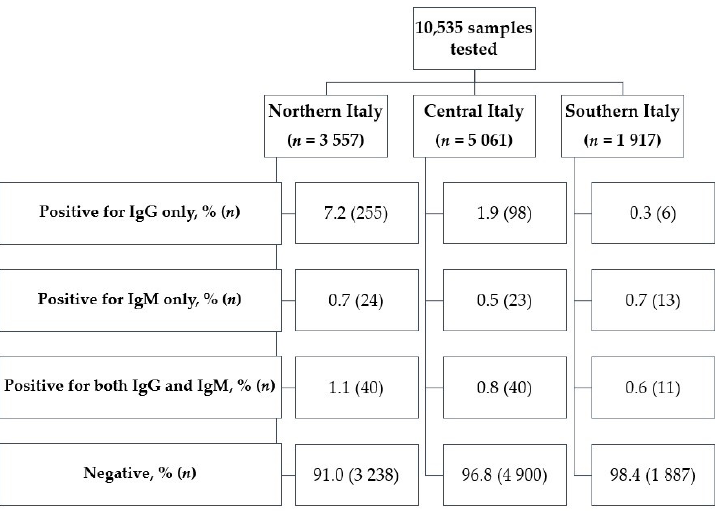
Figure 1. Distribution of seropositive and seronegative police officers, by macro-region. In the multivariable logistic model (Table 3), the main effect of the independent variables of geographic area, prior olfactory and gustatory dysfunctions and ILI were significantly associated with a positive test result. Moreover, two interaction terms proved statistically significant. First, males with dysosmia had a 91.9% probability of testing seropositive [adjusted OR (aOR) = 11.35], while the probability of seropositivity in females was 97.3% (aOR = 35.60). Secondly, olfactory dysfunction in patients with no ILI history had a higher prognostic value (aOR = 11.35) compared with those who reported some ILI symptoms (aOR = 4.35). Table 3. Multivariable logistic regression model to predict the SARS-CoV-2 seropositivity status ( n = 510). Characteristic